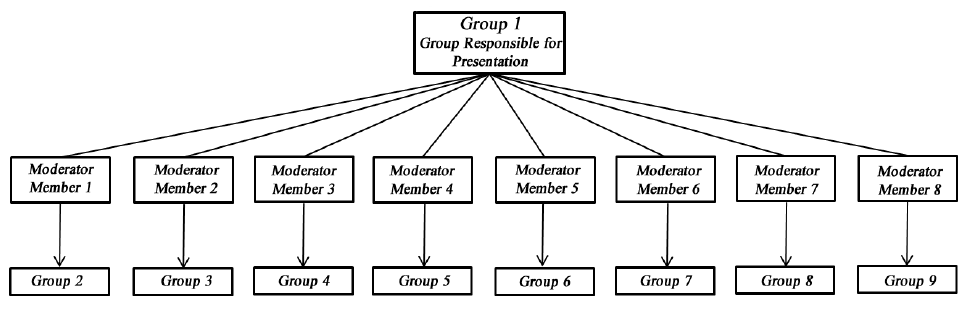
Figure 3. The model proposed by the SRM course designers for student